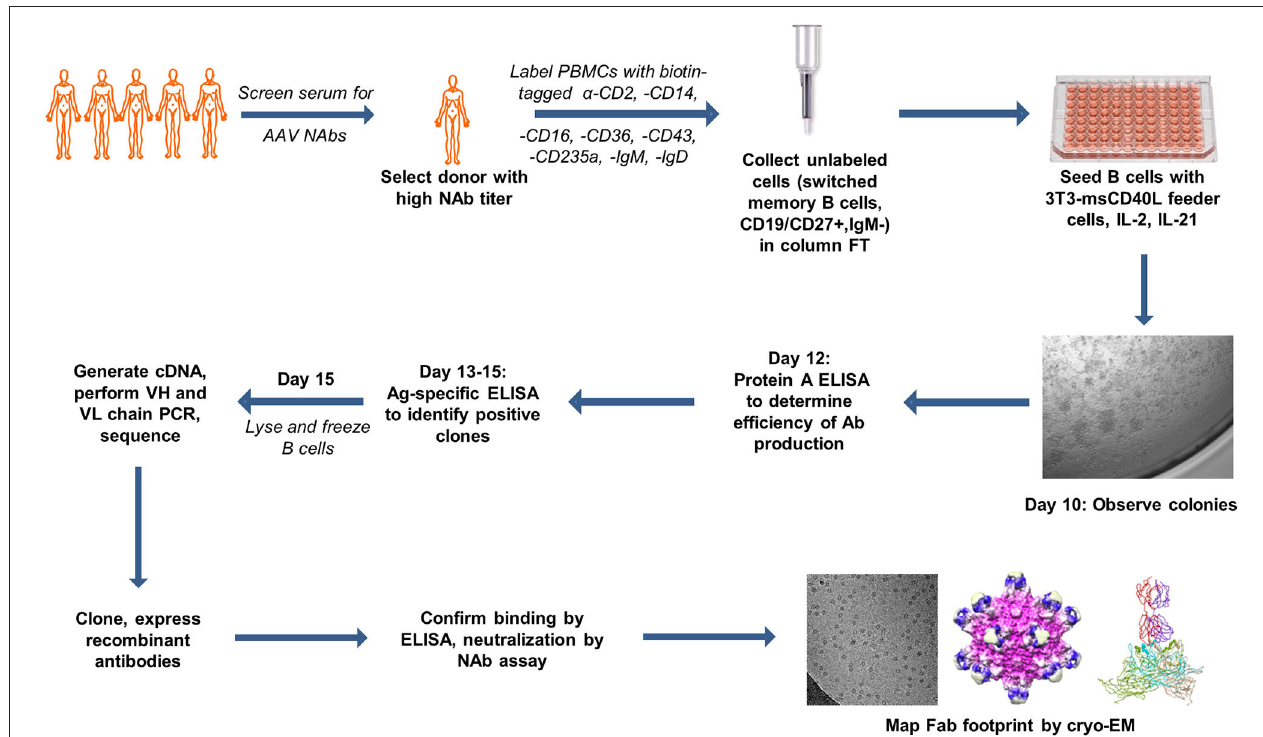
FIGURE 1 | Summary of antigen-independent isolation of human donor memory B cells for the cloning of fully human anti-AAV mAbs. The figure uses motifolio image assets (www.motifolio.com). Parts of this figure (3D structures) are adapted from Giles et al.